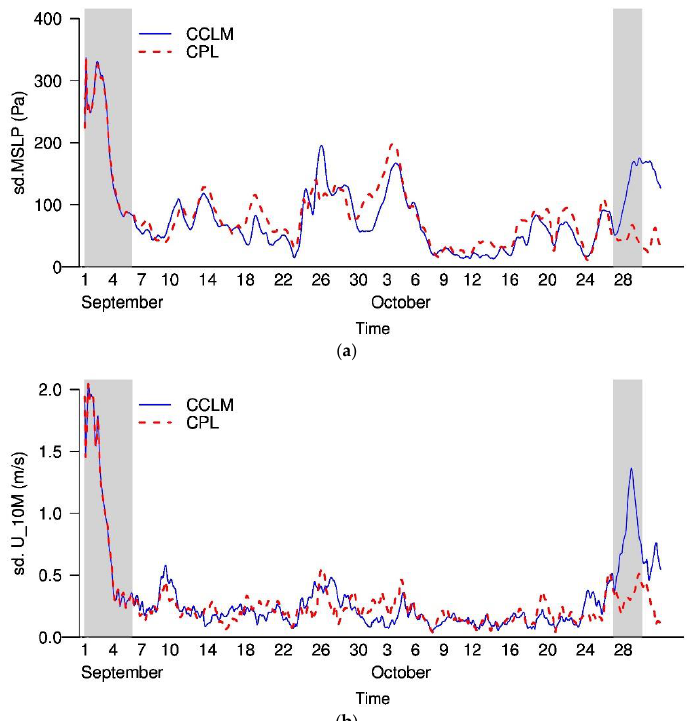
Figure 5. Hourly IV of ( a ) mean sea level pressure MSLP (Pa) and ( b ) 10-m height u-wind component U_10M spread (m/s) averaged over the NS_BS area. Time period: 1 September–31 October 2013. Grey bars mark the two periods 1–5 September 2013 and 27–29 October 2013. Atmosphere 2020 , 11 , x FOR PEER REVIEW